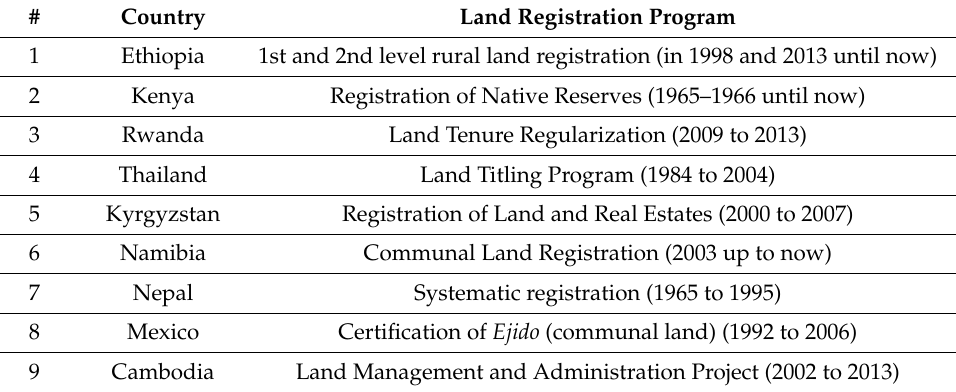
Table 1. Explored land registration